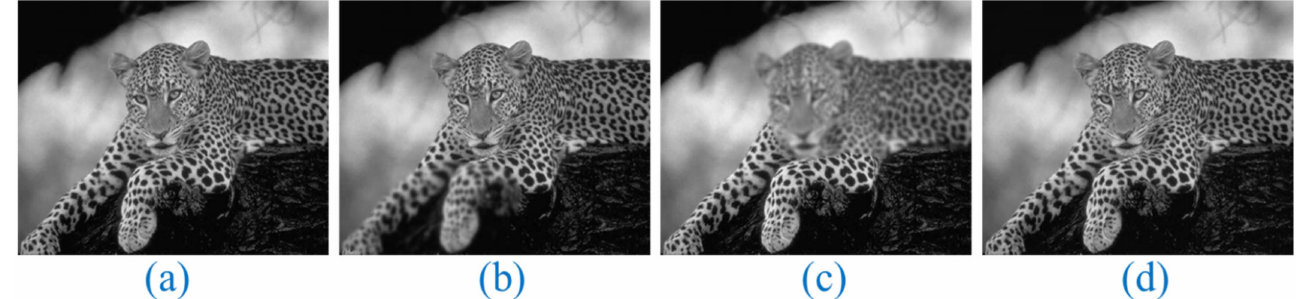
Figure 4. Multi-focus image of a leopard from various perspectives. Original Image: ( a ), Multi-focus Input Images: ( b , c ), and Proposed Fusion: ( d ).